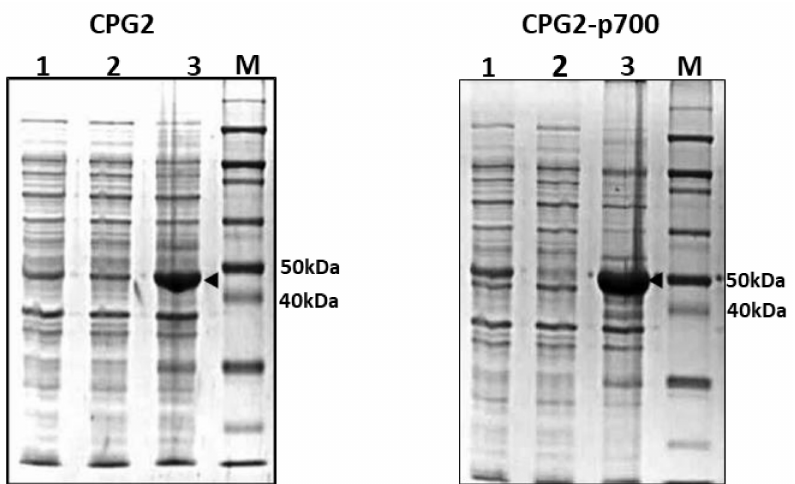
Figure 1. Solubility test to determine localisation of recombinant CPG2 protein expression in BL21 E. coli. Coomassie Blue staining following SDS-PAGE of samples of whole cell lysate (lane 1), supernatant (lane 2) and re-suspended pellet (lane 3) of IPTG induced BL21 E. coli expressing CPG2 and CPG2-p700 proteins, respectively, from left to right, along with protein standards (ladder). The arrowheads indicate over-expressed CPG2 and CPG2-p700 proteins at the expected sizes (45 and 48 kDa, respectively) in the re-suspended